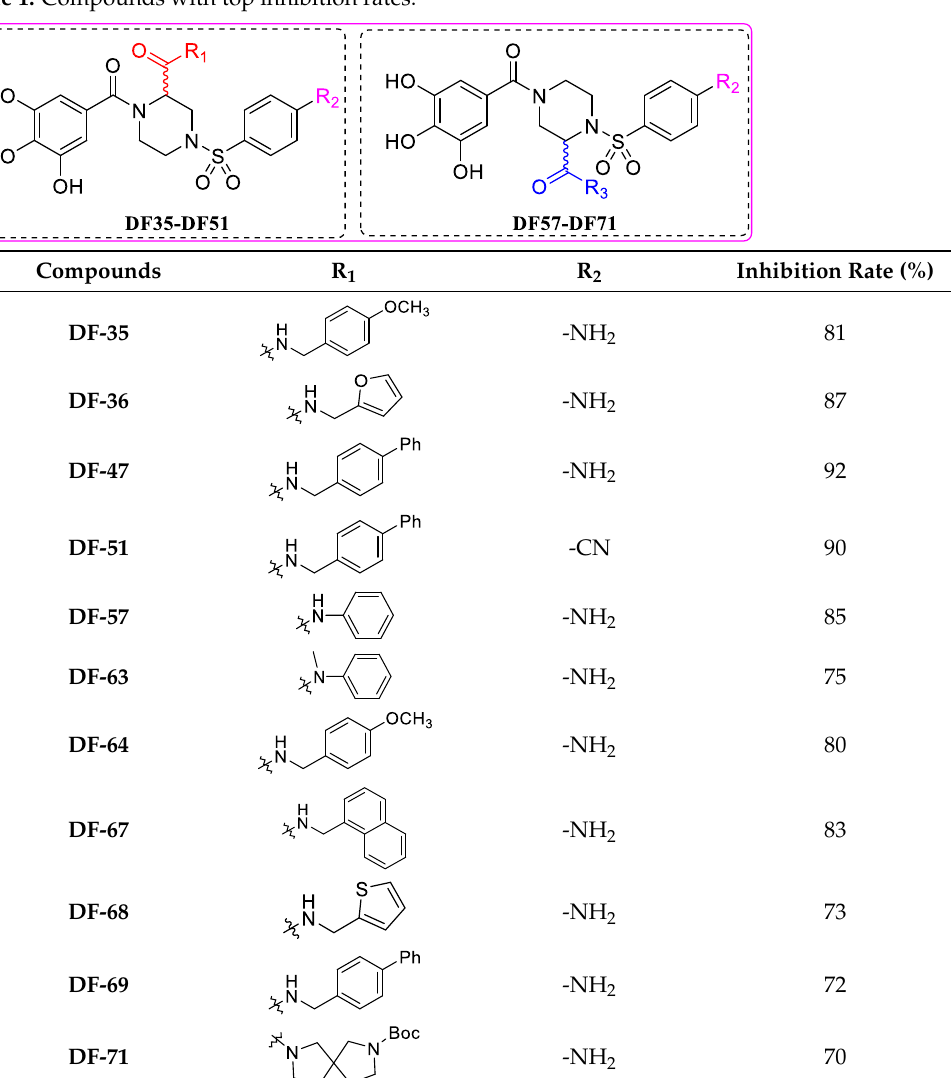
Table 1. Compounds with top inhibition rates.